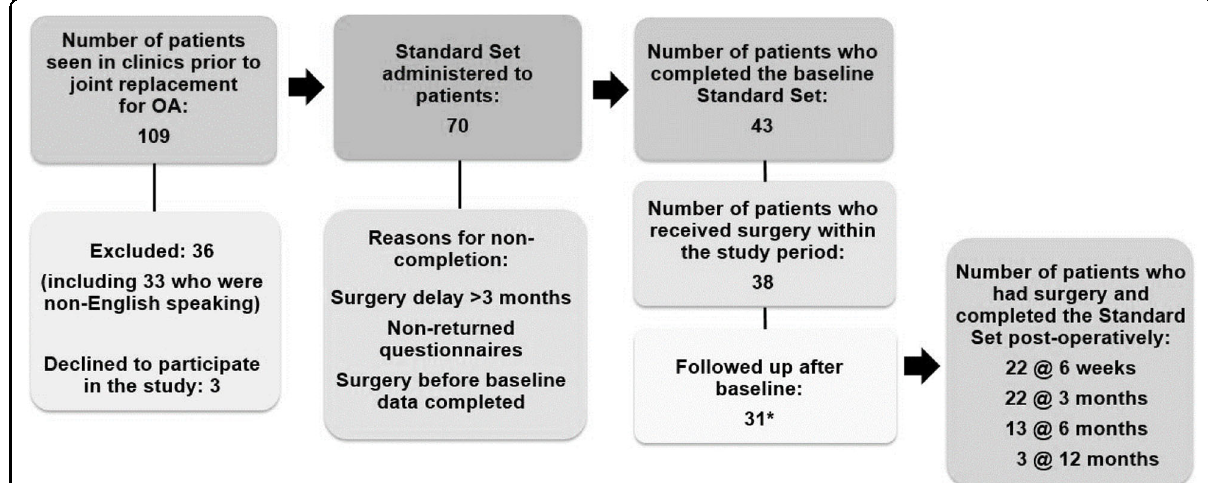
Fig. 2 Flow of study participants. * 7 participants were not followed up beyond baseline for the following reasons: delay of > 3 months between baseline and their surgery ( n = 5); evident post-operative cognitive impairment ( n =